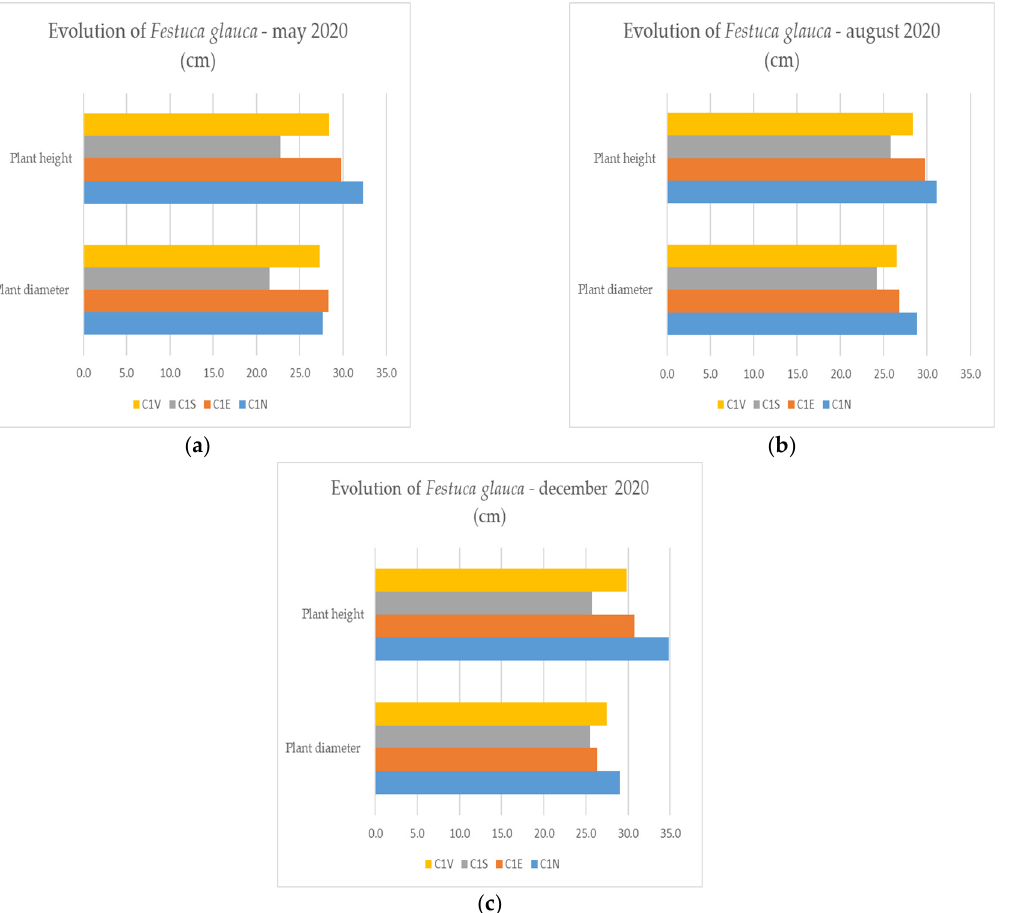
Figure 12. Evolution of height and diameter at Festuca glauca , May–December 2020 on cardinal orientations: ( a ) May; ( b ) August; and ( c ) December.